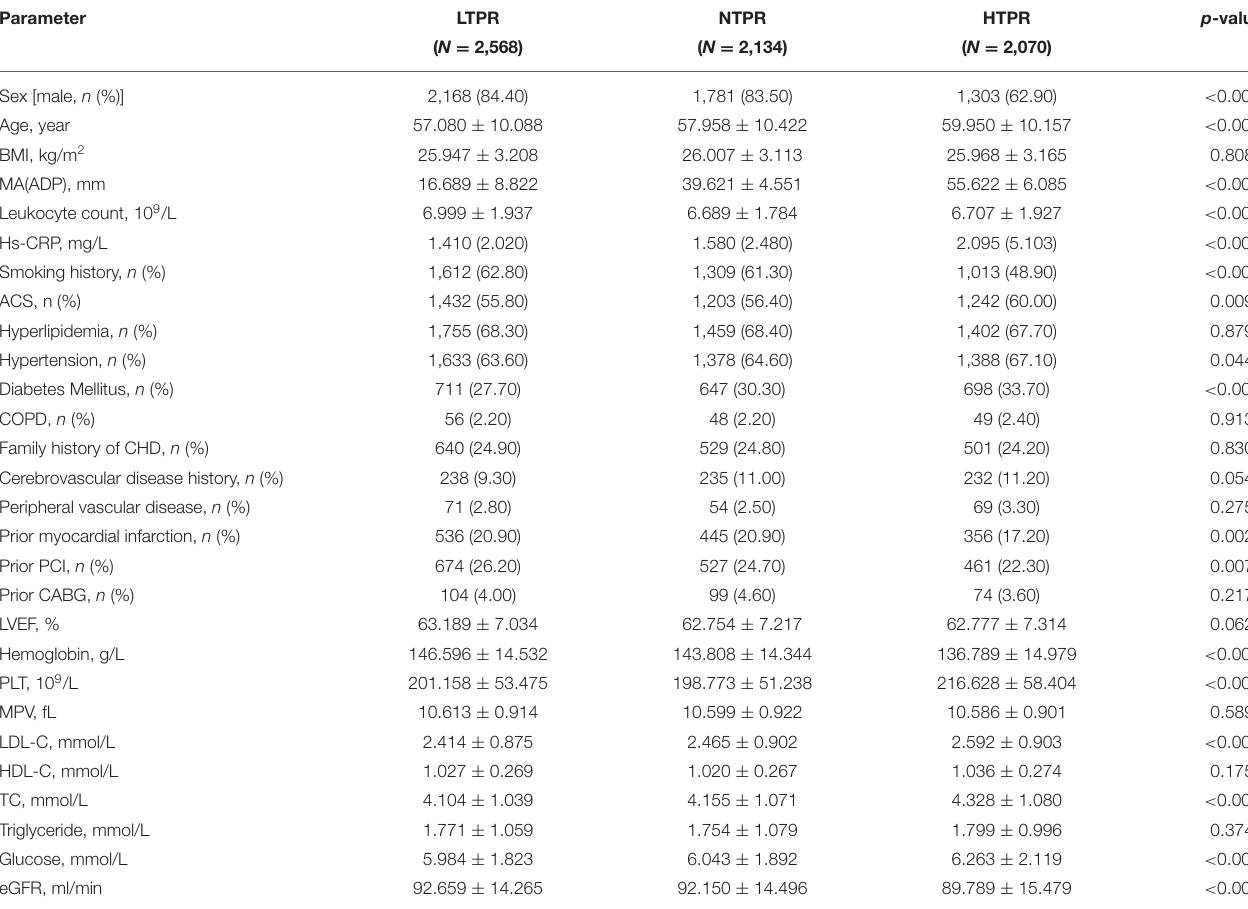
TABLE 1 | Baseline characteristics of patients according to platelet